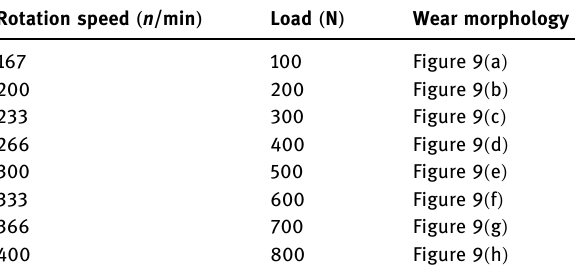
Table 7: Working conditions and wear